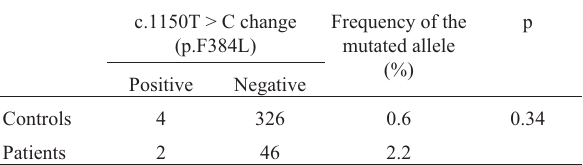
Table 2 - Frequency of the c.1150T > C change in both - control individu- als and patients with pathogenic mutations in the FGFR3